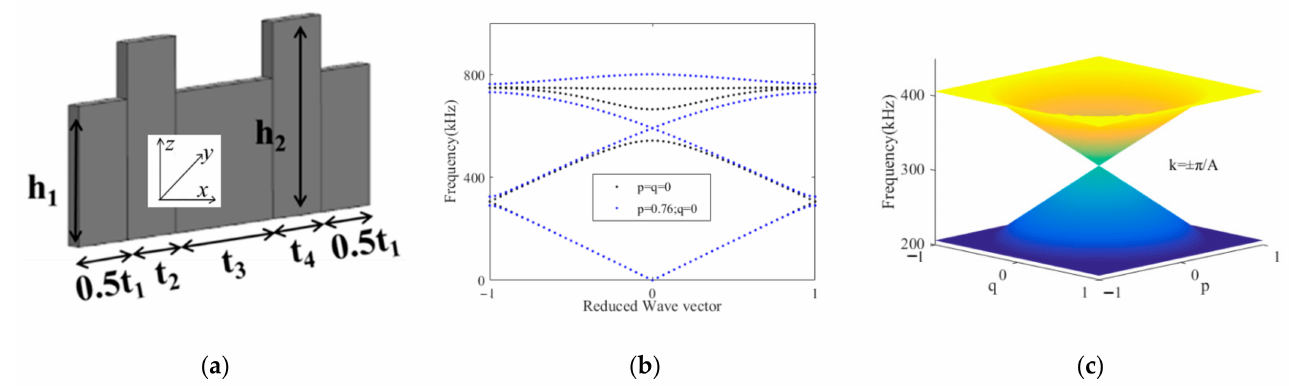
Figure 1. The synthetic Weyl points in 1D PC plates. ( a ) The unit cell consists of four layers. ( b ) Dispersion curves with different p and q values ( c ) Bulk dispersions plotted for bands 1 and 2 with the wave vector plus two structural